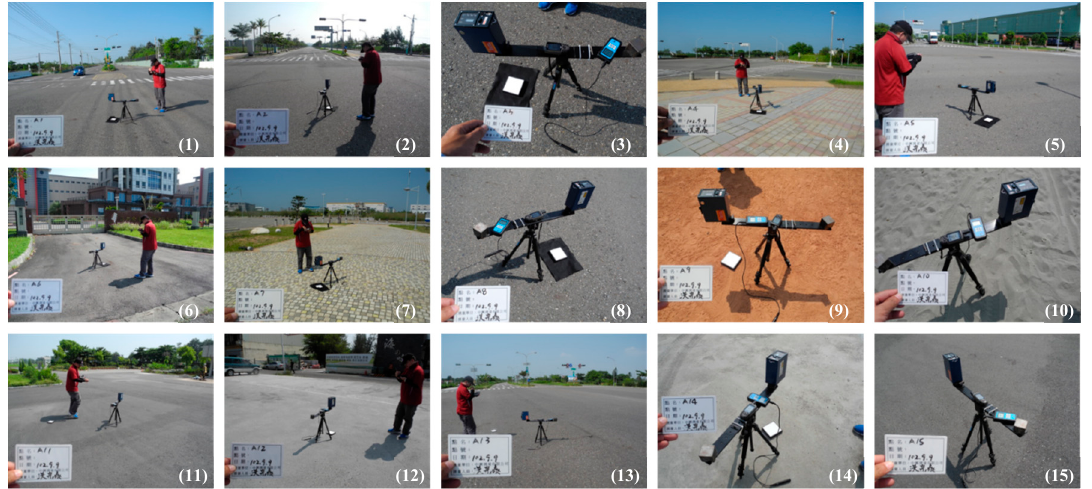
Figure 3. The field photographs of the 15 sites: (1) Asphalt, (2) Asphalt, (3) Asphalt, (4) Floor tiles, (5) Asphalt, (6) Asphalt, (7) Floor tiles, (8) Asphalt, (9) Red soil, (10) Sand, (11) Asphalt, (12) Cement, (13) Asphalt, (14) Cement, (15) Asphalt.